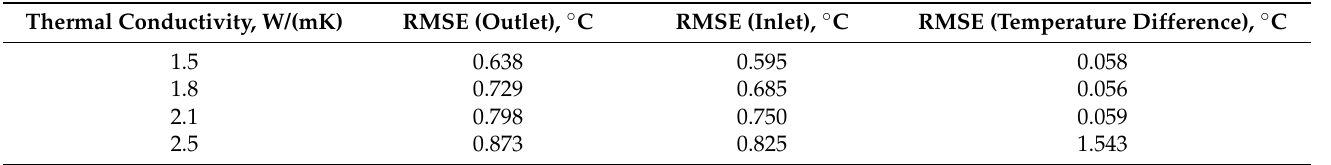
Table 3. Validation parameters. Comparison between numerical and experimental inlet and outlet temperatures. Thermal Conductivity,